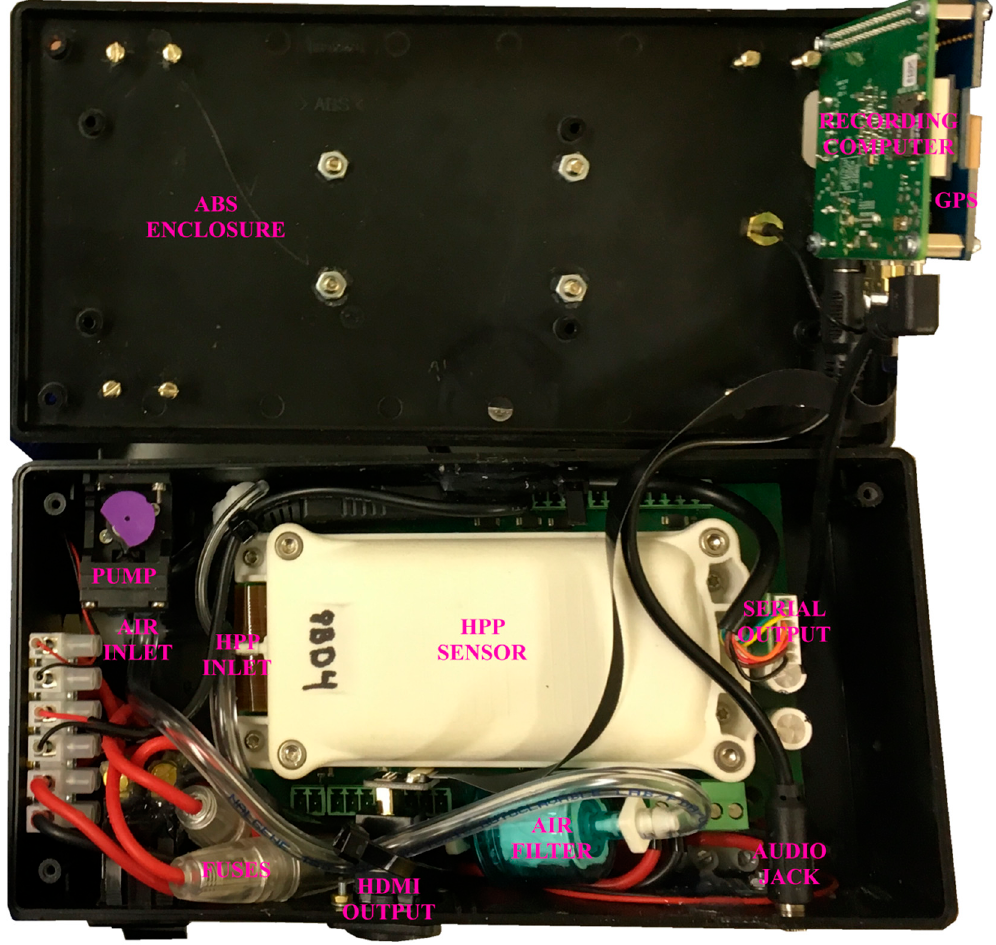
Figure 1. The packaged sensor with the enclosure lid opened and significant operating components